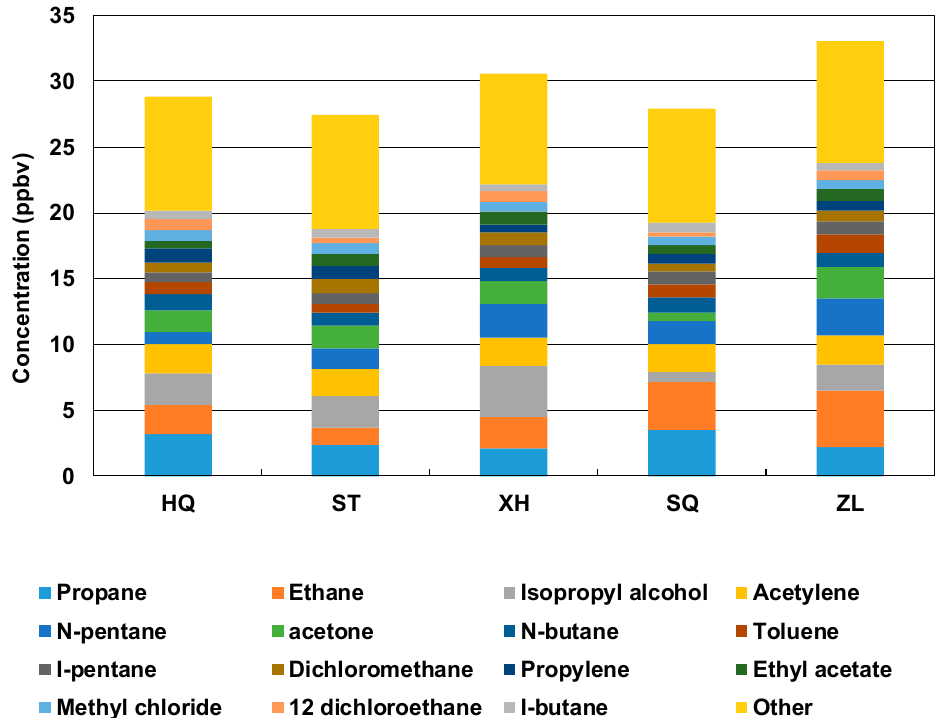
Figure 2. Volatile organic compound (VOC) concentrations at the five sampling sites.